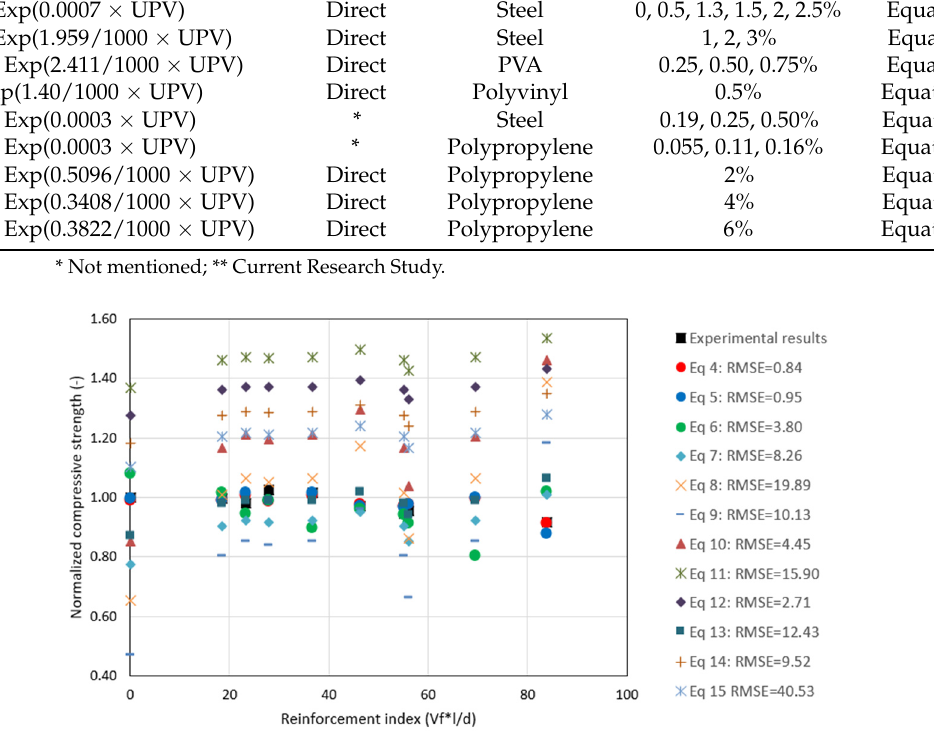
Figure 20. Normalized comparison between compressive strength prediction equations based on UPV.